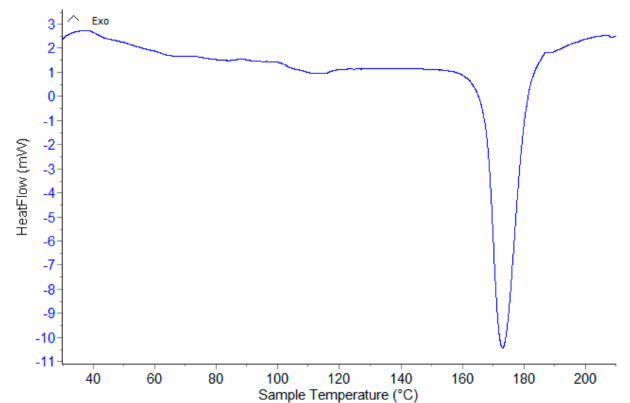
Figure A1. The DSC thermogram of RUT, dynamic nitrogen atmosphere, β = 10 K min − 1